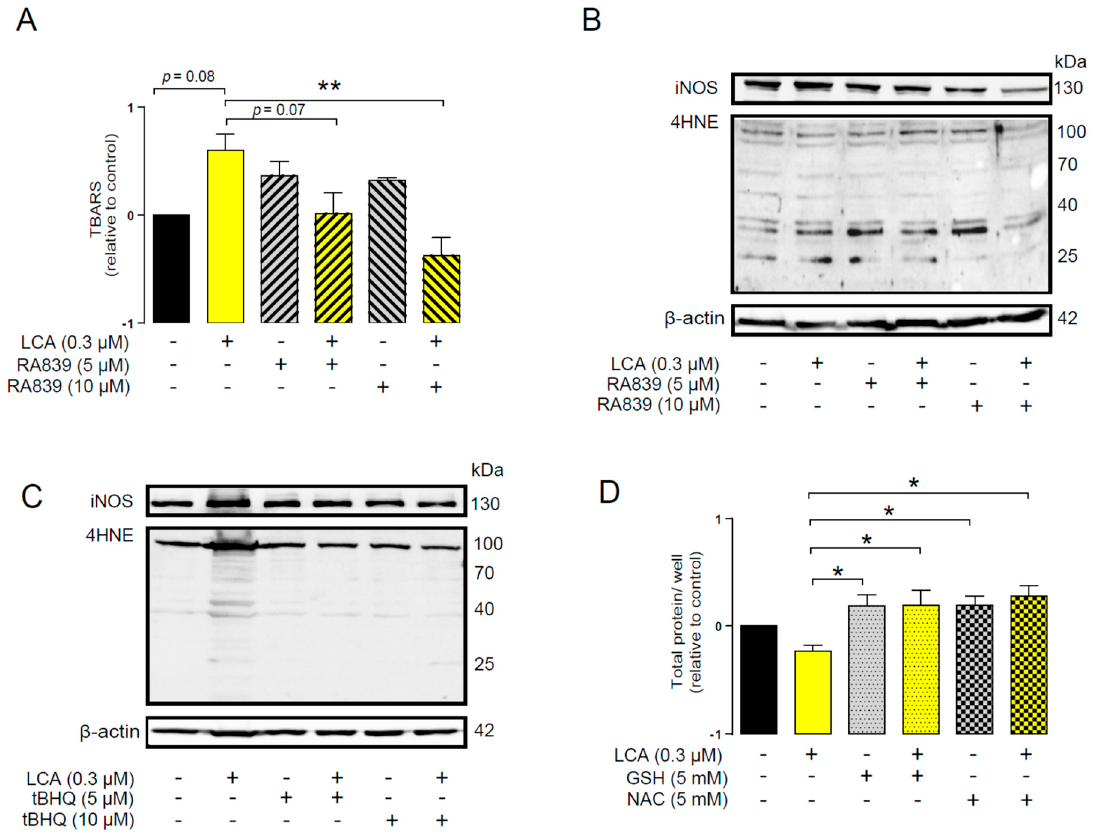
Figure 5. NRF2 activation modulated LCA-induced oxidative stress responses in 4T1 breast cancer cells. The 4T1 cells were treated with 0.3 µm LCA and the NRF2 activator RA839 or tBHQ in the concentrations indicated for 48 h. Lipid peroxidation was determined by measuring ( A ) TBARS ( n = 4) and ( B , C ) 4-HNE levels using western blotting ( n = 3). ( D ) The 4T1 cells were treated with LCA (0.3 µm) and/or GSH and NAC (both at 5 mm) antioxidants for 48 h, then total protein concentration was determined using the sulforhodamine B assay ( n = 3). For statistical analysis ANOVA test was used followed by the Dunnett post-hoc test, where all groups were compared to the LCA-treated cohort. Data are plotted as mean ± SEM. ** p < 0.01, LCA vs. LCA/NRF2-activator-treated groups (GSH, reduced glutathione; LCA, lithocholic acid; NAC, N-acetylcysteine; TBARS, thiobarbituric acid reactive substances; 4HNE, 4-hydroxynonenal).